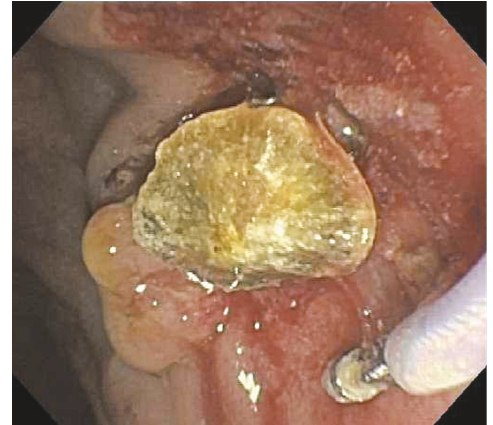
Figure 3: Case # 2, Gallstone in duodenum removed by ERCP sphincterotomy, balloon dilation, and basket procedure.